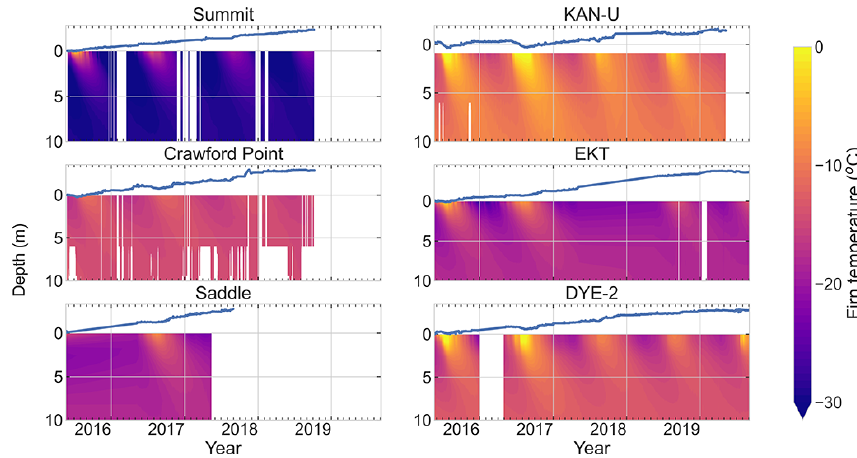
Figure 7. Firn temperatures (interpolated) and surface height (solid blue line) observed at the FirnCover stations. Table 5. Average 10m firn temperatures for the 2015–2019 period along with average air temperature at each site and difference between the two. Only years that have more than 90% available temperature readings are used for the average.